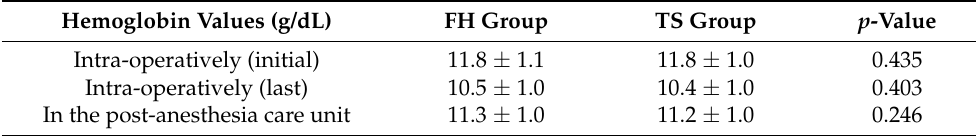
Table 5. Hemoglobin values during and after the surgery. Hemoglobin Values (g/dL)